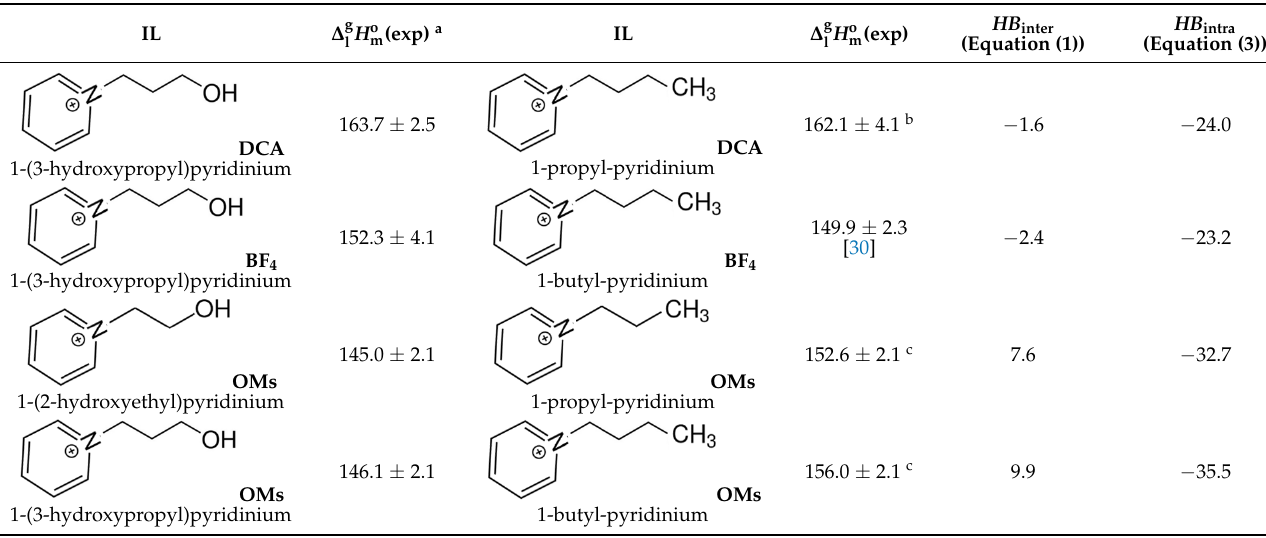
a Experimental data from Table 4. b Enthalpy of vaporisation of 1-propyl-pyridinium [DCA] is supposed to be equal to those of 3-methyl-1-propyl-pyridinium [DCA] derived in our previous work [31]. c Enthalpy of vaporisation was assessed as shown in Figures S3 and S4.